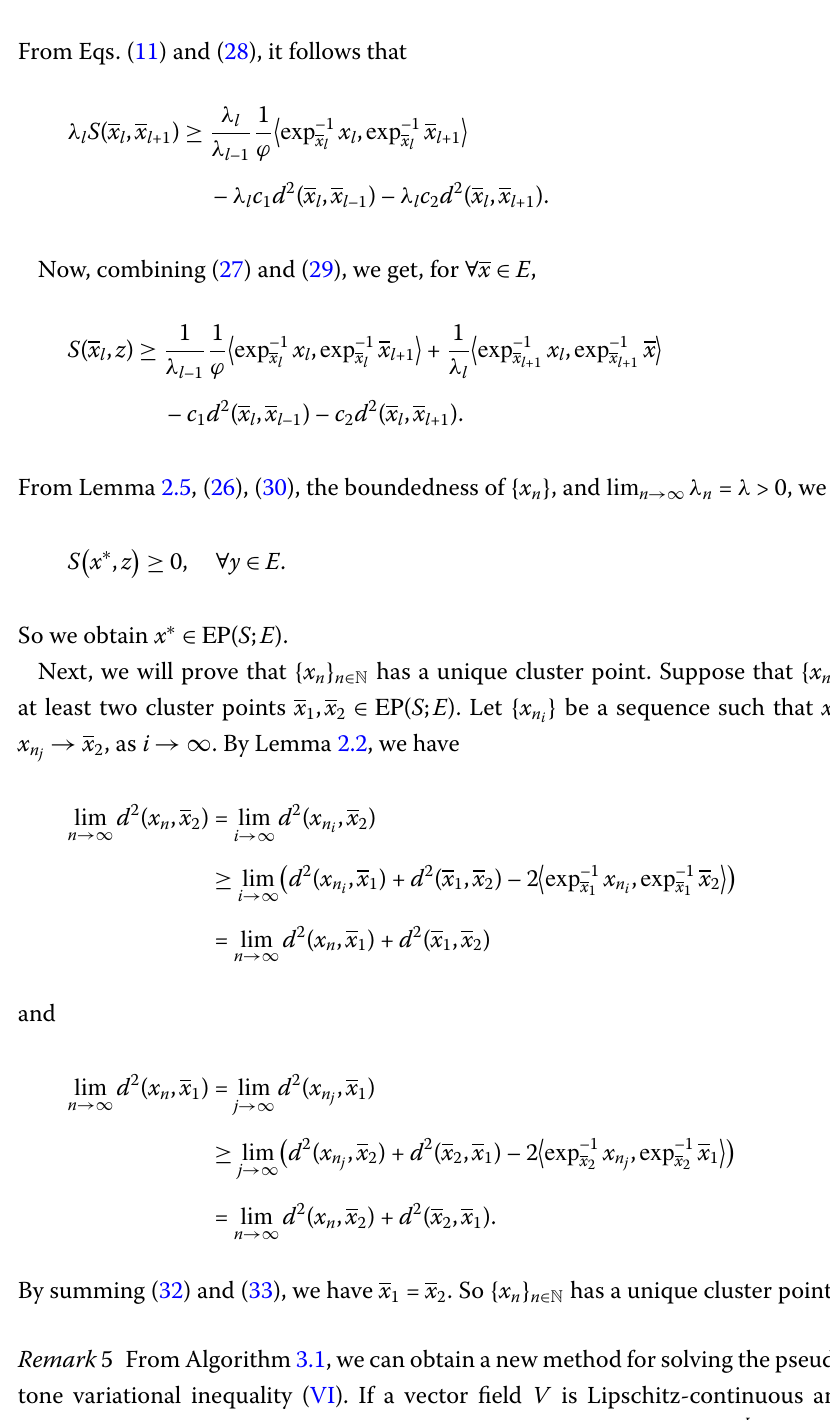
Algorithm 3.2 (Extragradient-like algorithm for solving